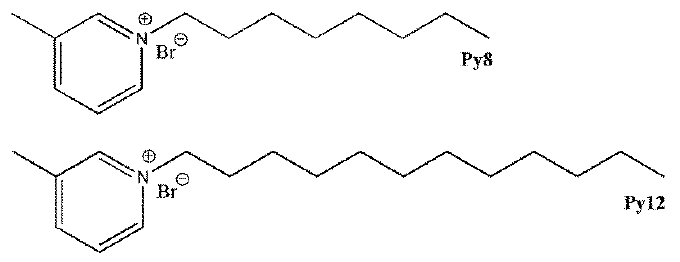
Figure 1. Chemical structure of the inhibitors.